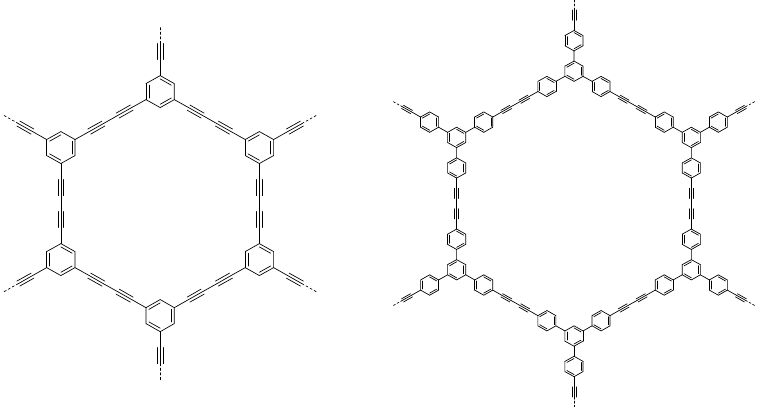
Figure 29. Structures of PTEB and PTEPB CMPs